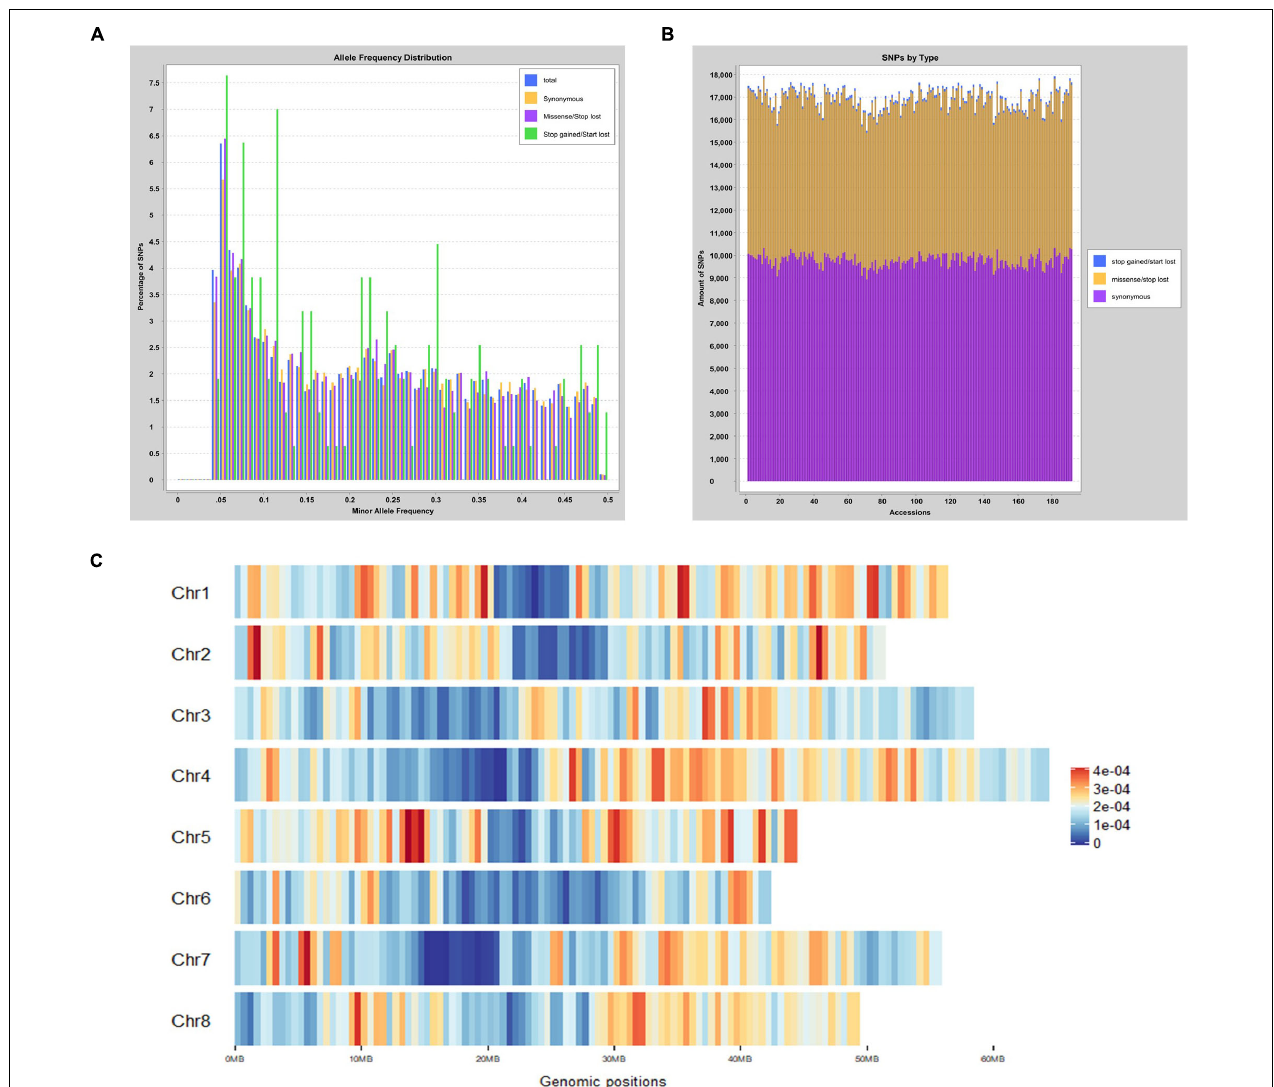
FIGURE 1 | Distribution of MAF and SNP across the Medicago truncatula genome. (A) Distribution of MAF from 0.05 to 0.5. Different types of variants were displayed in three colors. Synonymous variants are shown in yellow, whereas missense/stop lost variants and stop gained/start lost variants are shown in purple and green, respectively. (B) Statistics of three different types variants. Each accession is presented in a single vertical bar. The proportion of variants including synonymous, missense/stop lost, and stop gained/start lost were shown in purple, yellow, and blue, respectively. (C) SNP distribution and density on each chromosome. Loci with high density SNPs were shown in red color, whereas low density SNPs were shown as blue. The marker at the bottom displays the lengths of each chromosome and the positions of